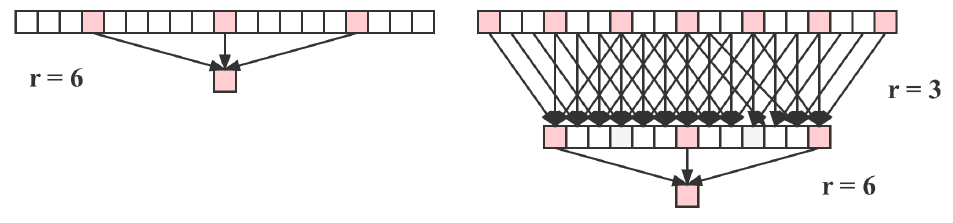
Figure 4. The effect of dilated convolution layers with different structures on pixel sampling.